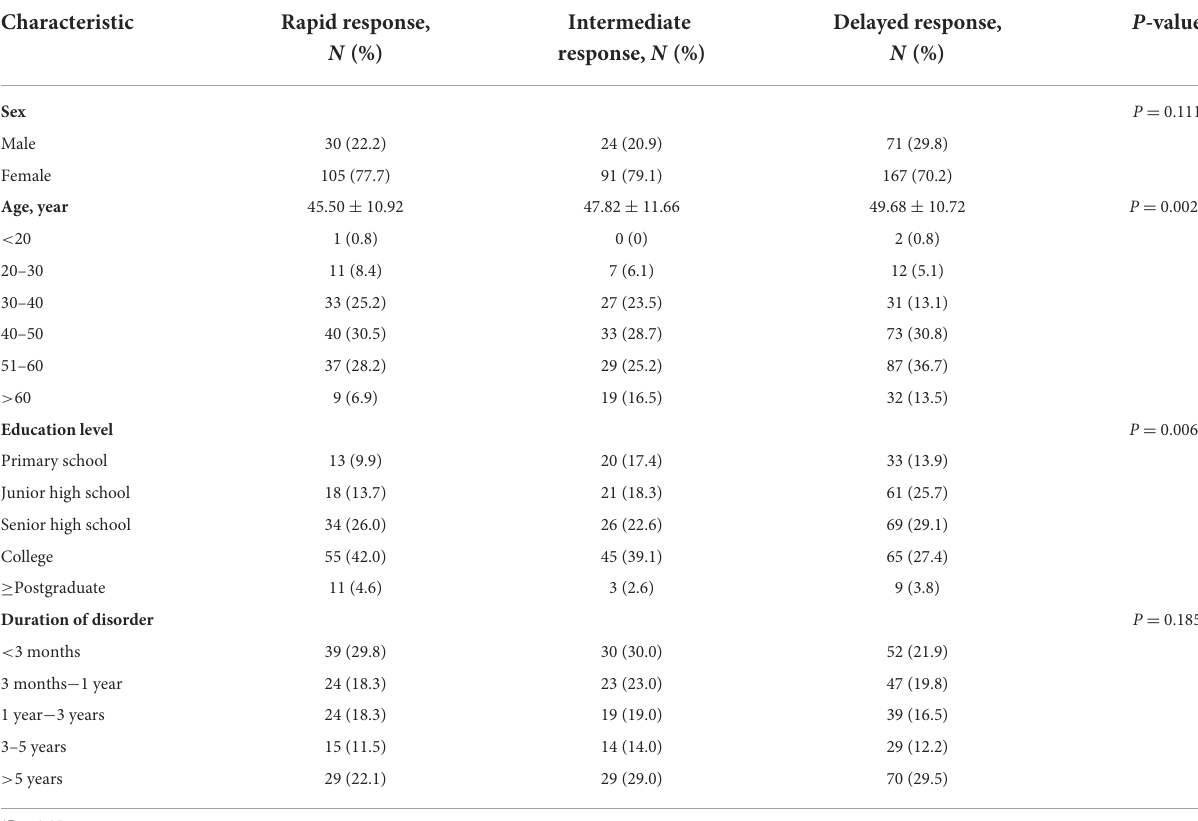
TABLE 1 Demographic characteristics of participants.